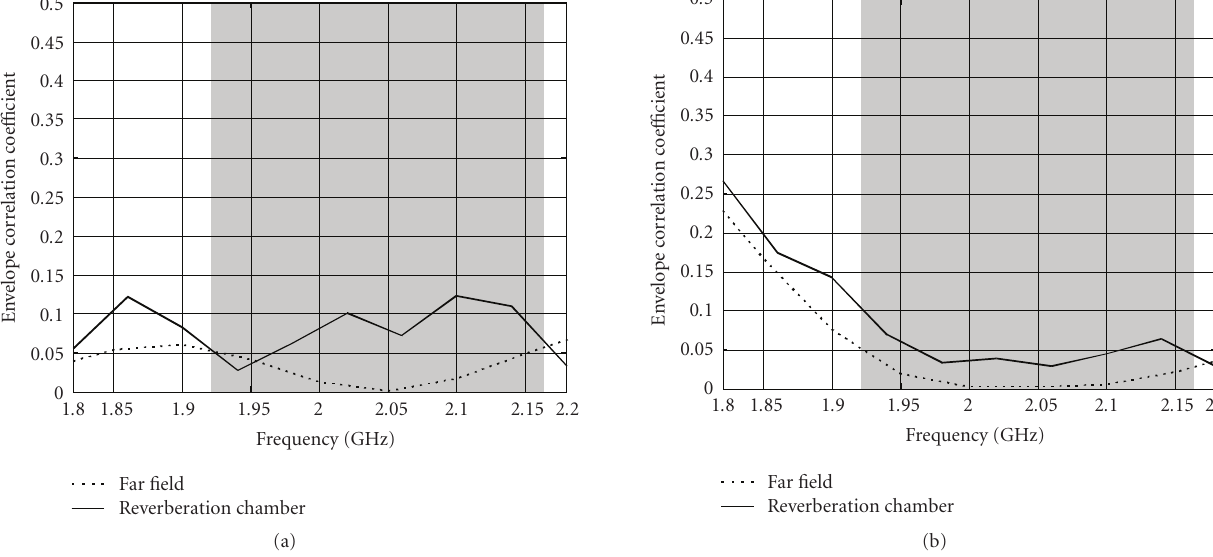
Figure 7: Simulated (3D patterns) and measured (reverberation chamber) envelope correlation coe ffi cient of the two antenna systems; (a) initial structure, (b) neutralized structure.